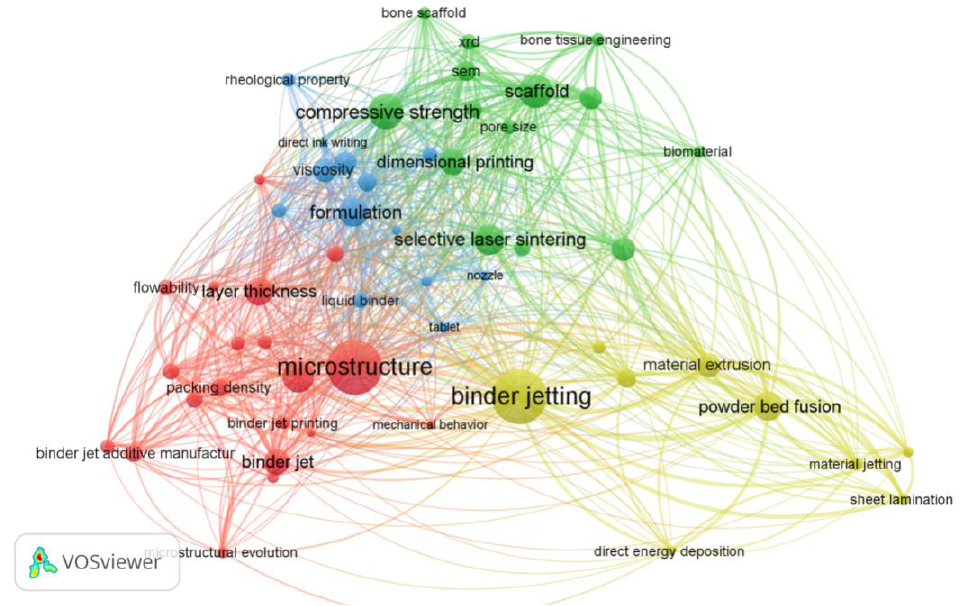
Figure 1. VOS viewer network visualization map of 3D printing/Rapid prototyping/Additive manufacturing technology involved in pharmacy and orthopedics.